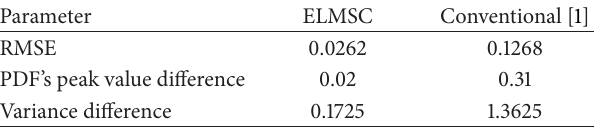
Table 5: Comparison with the measured